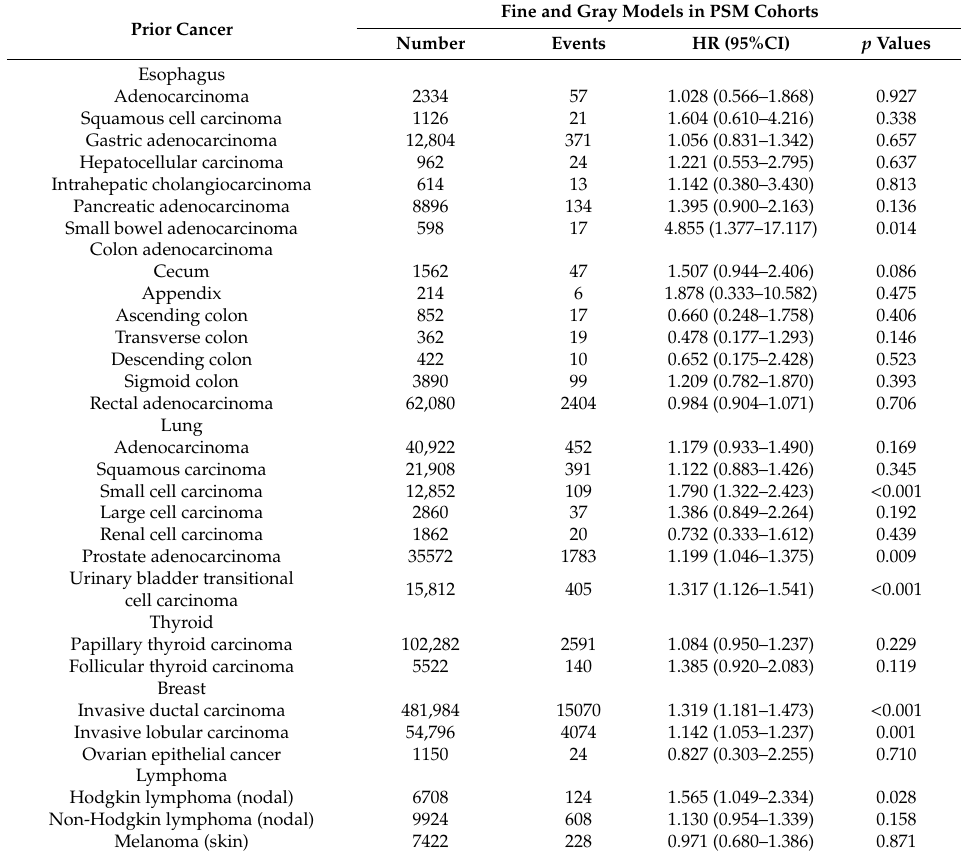
Table 2. The risk for secondary malignancies after radiation in pan-cancers after PSM. Prior